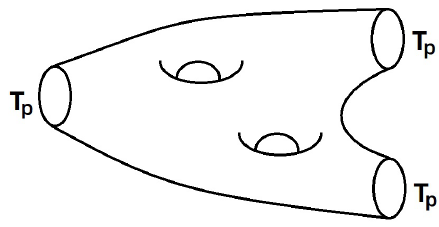
Figure 4 . The surface shown has genus h = 2 with k = 3